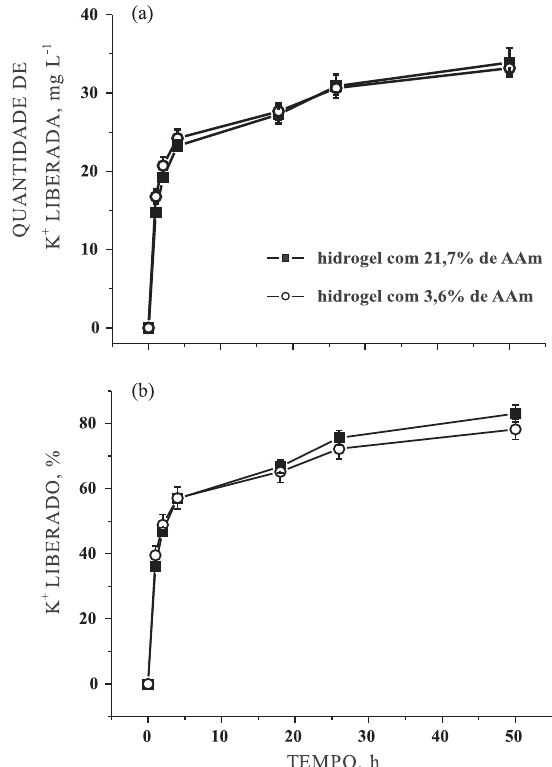
Figura 4. Perfil de liberação controlada de K + contido em fosfato monobásico de potássio em função do tempo a partir de hidrogéis de